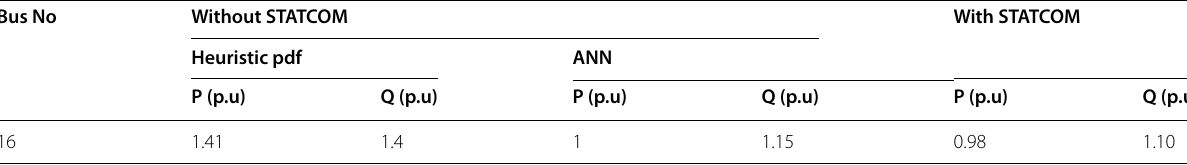
Table 27 Power flow comparison with and without presence of STATCOM at bus 16 of IEEE 57- bus system Bus No Without STATCOM With